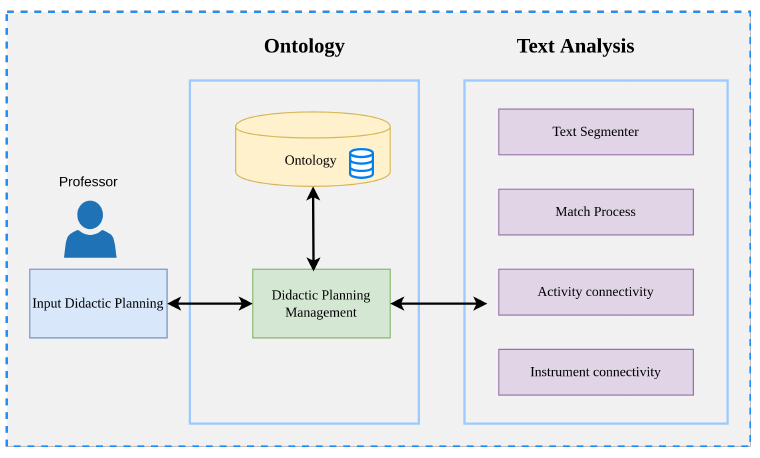
Figure 1. Framework